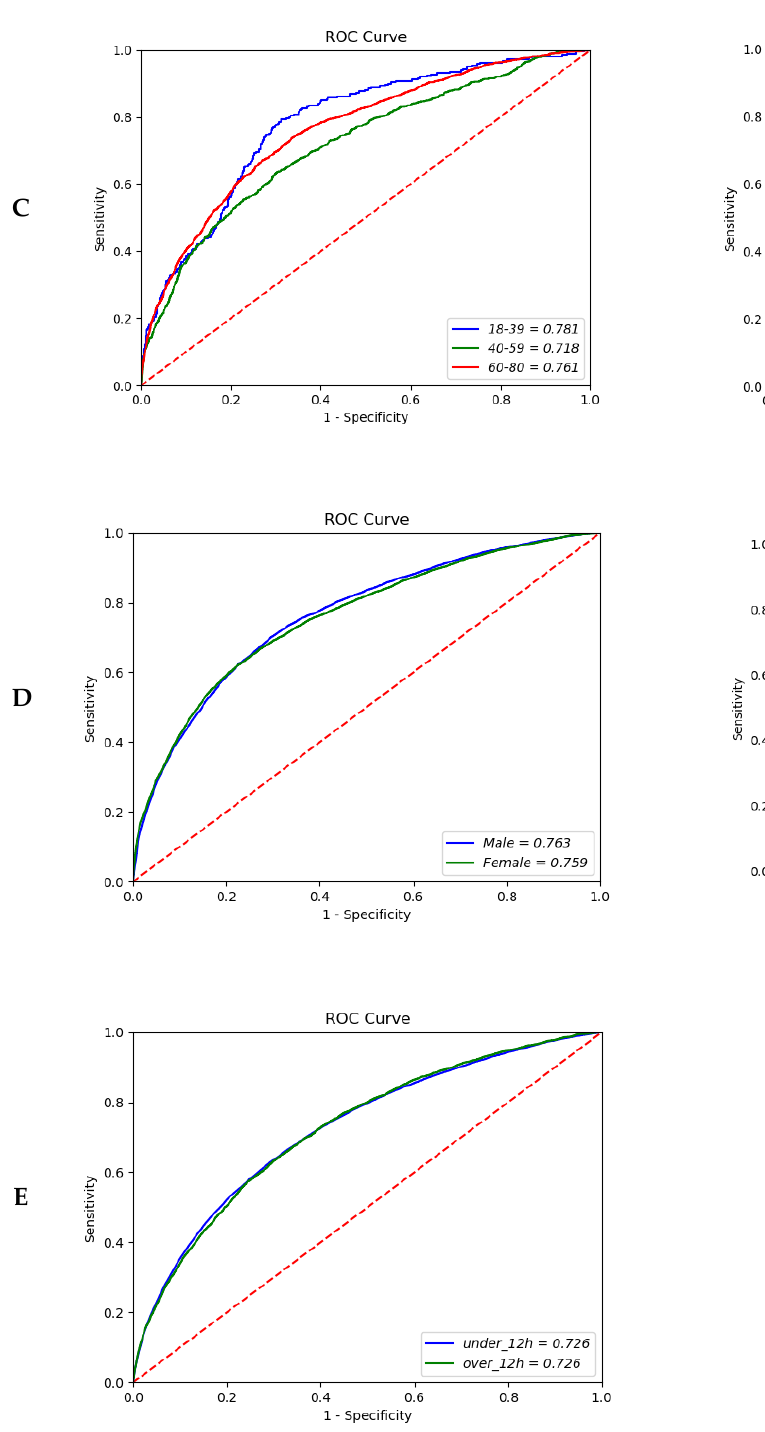
Figure 2. Area under the receiver operating characteristic curve of the bacteremia prediction. ( A ) Type of pathogen (12-h vs. 24-h model); ( B ) Site of infection (12-h vs. 24-h model); ( C ) Age (12-h vs. 24-h model); ( D ) Sex (12-h vs. 24-h model); ( E ) Merge hour (24-h model).